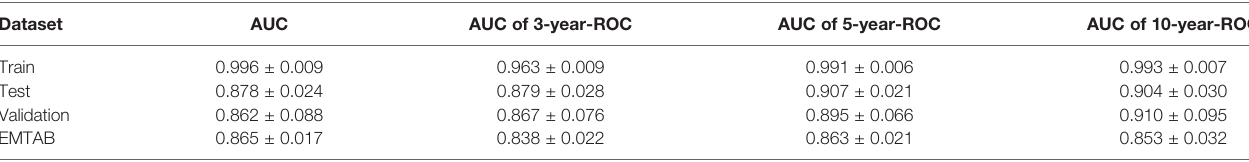
TABLE 1 | AUCs of ROCs, 3-year-ROC, 5-year-ROC and 10-year-ROC with 20 times 10-fold cross validation. Dataset